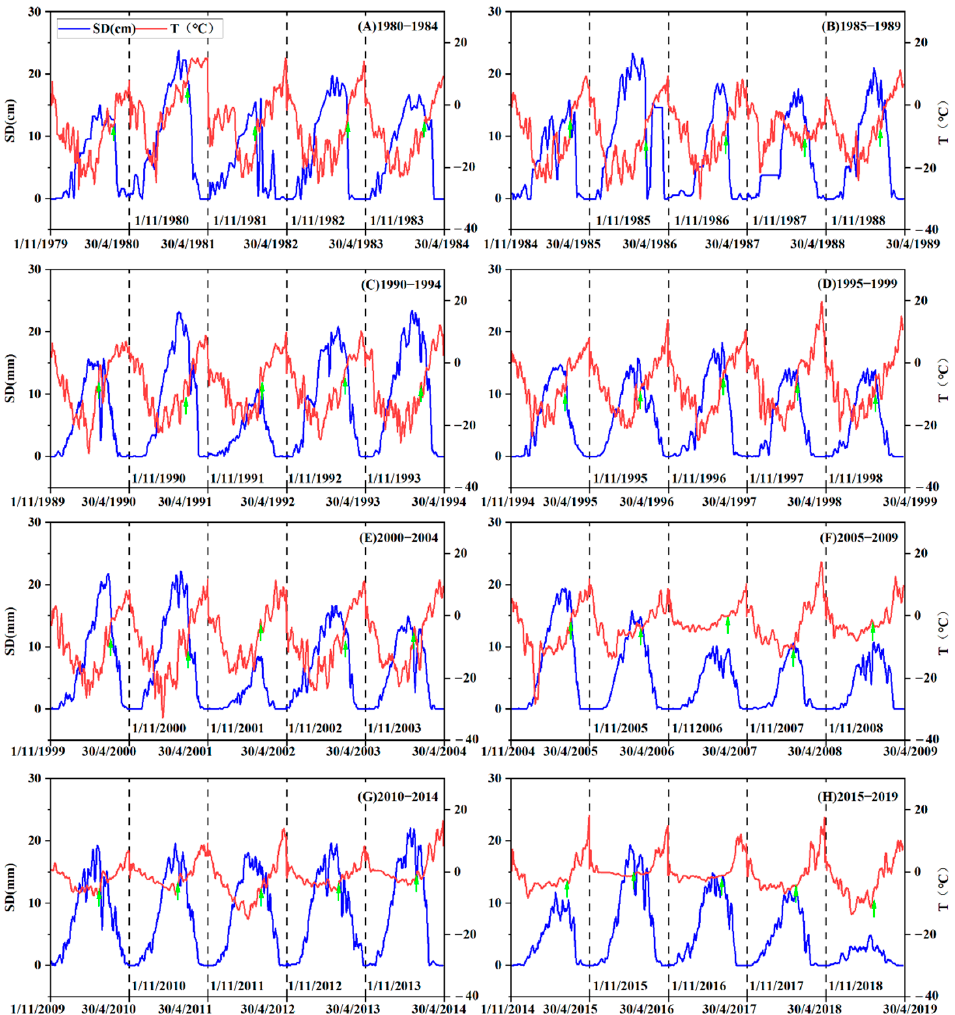
Figure 4. ( A – H ) Relationship between snow depth (SD (cm)) and temperature (T (°C)) of November to April in the next year during 1980–2019. Green arrows indicate the snowmelt temperature threshold.